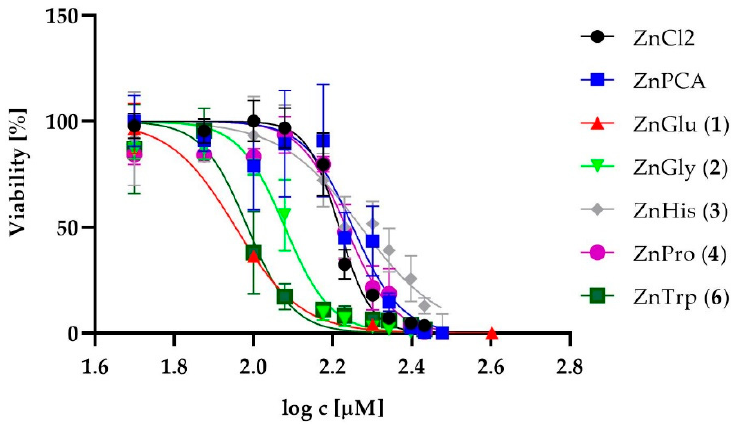
Figure 1. The normalized dose-response curves for the analyzed zinc complexes and reference compounds against fibroblasts.